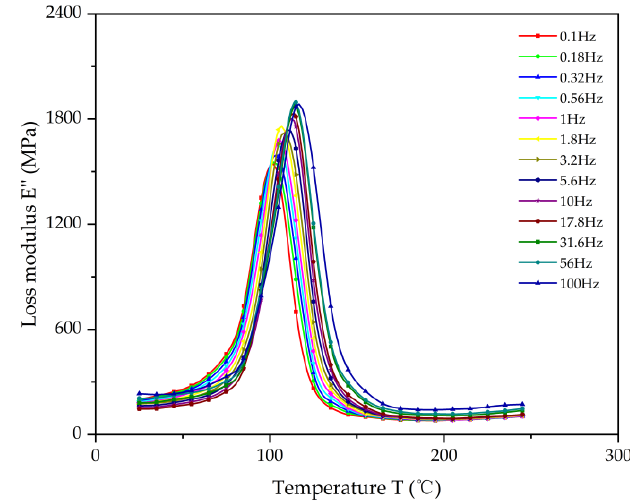
Figure 5. Loss modulus vs. temperature at different frequencies.